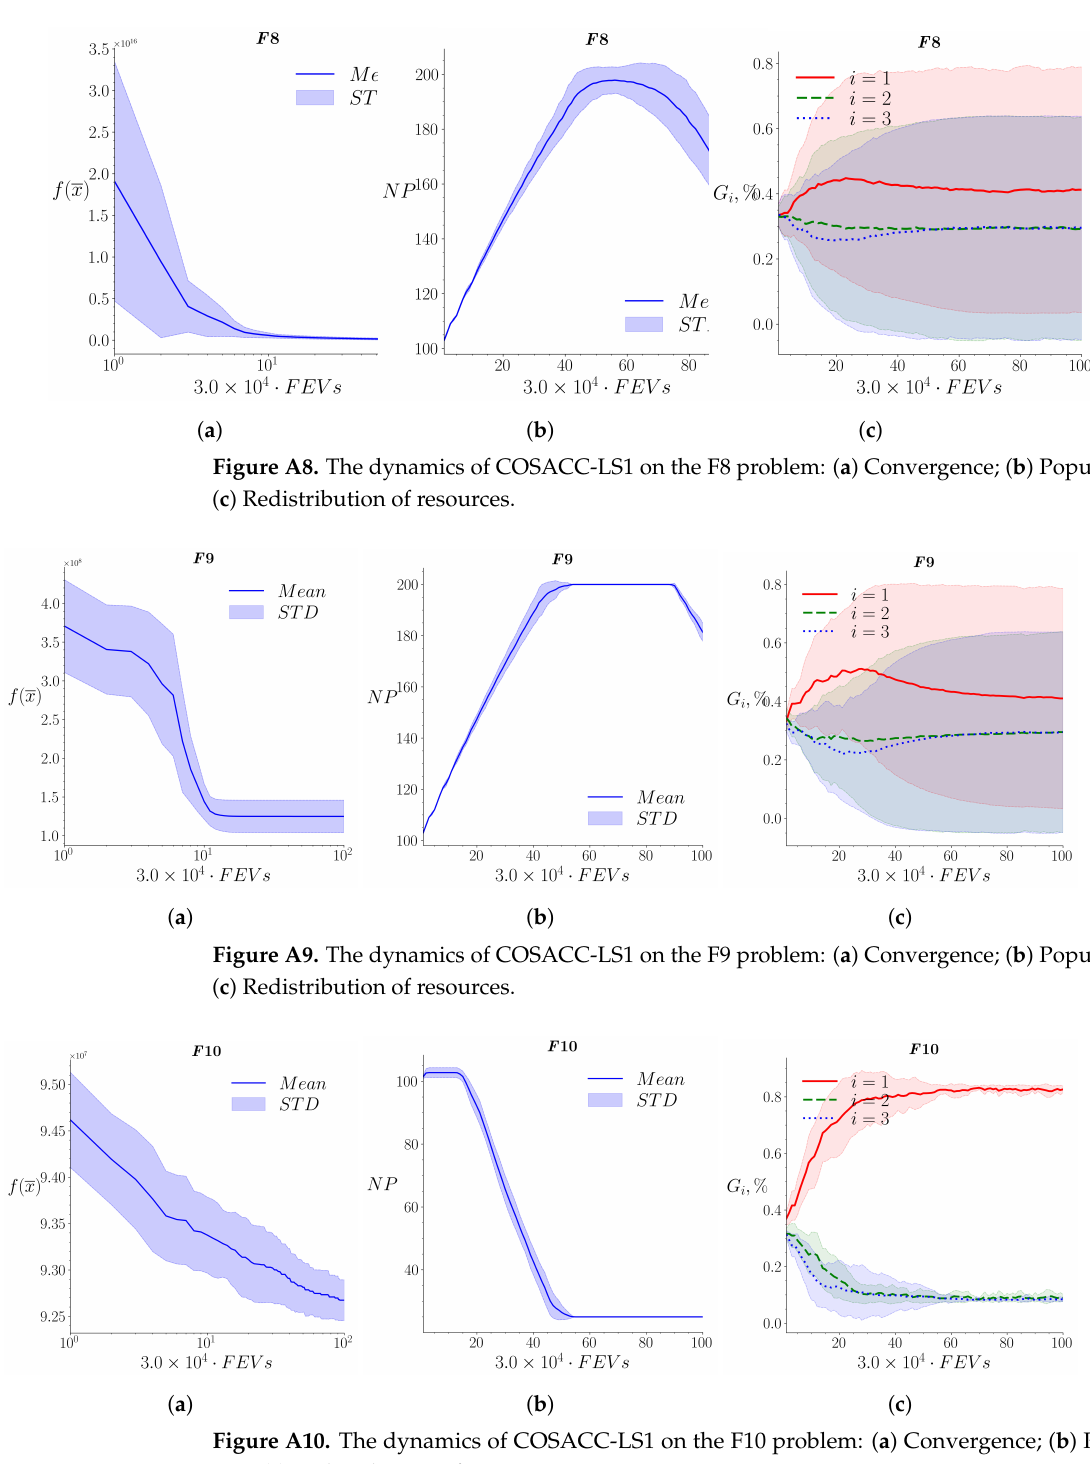
Figure A10. The dynamics of COSACC-LS1 on the F10 problem: ( a ) Convergence; ( b ) Population size; ( c ) Redistribution of